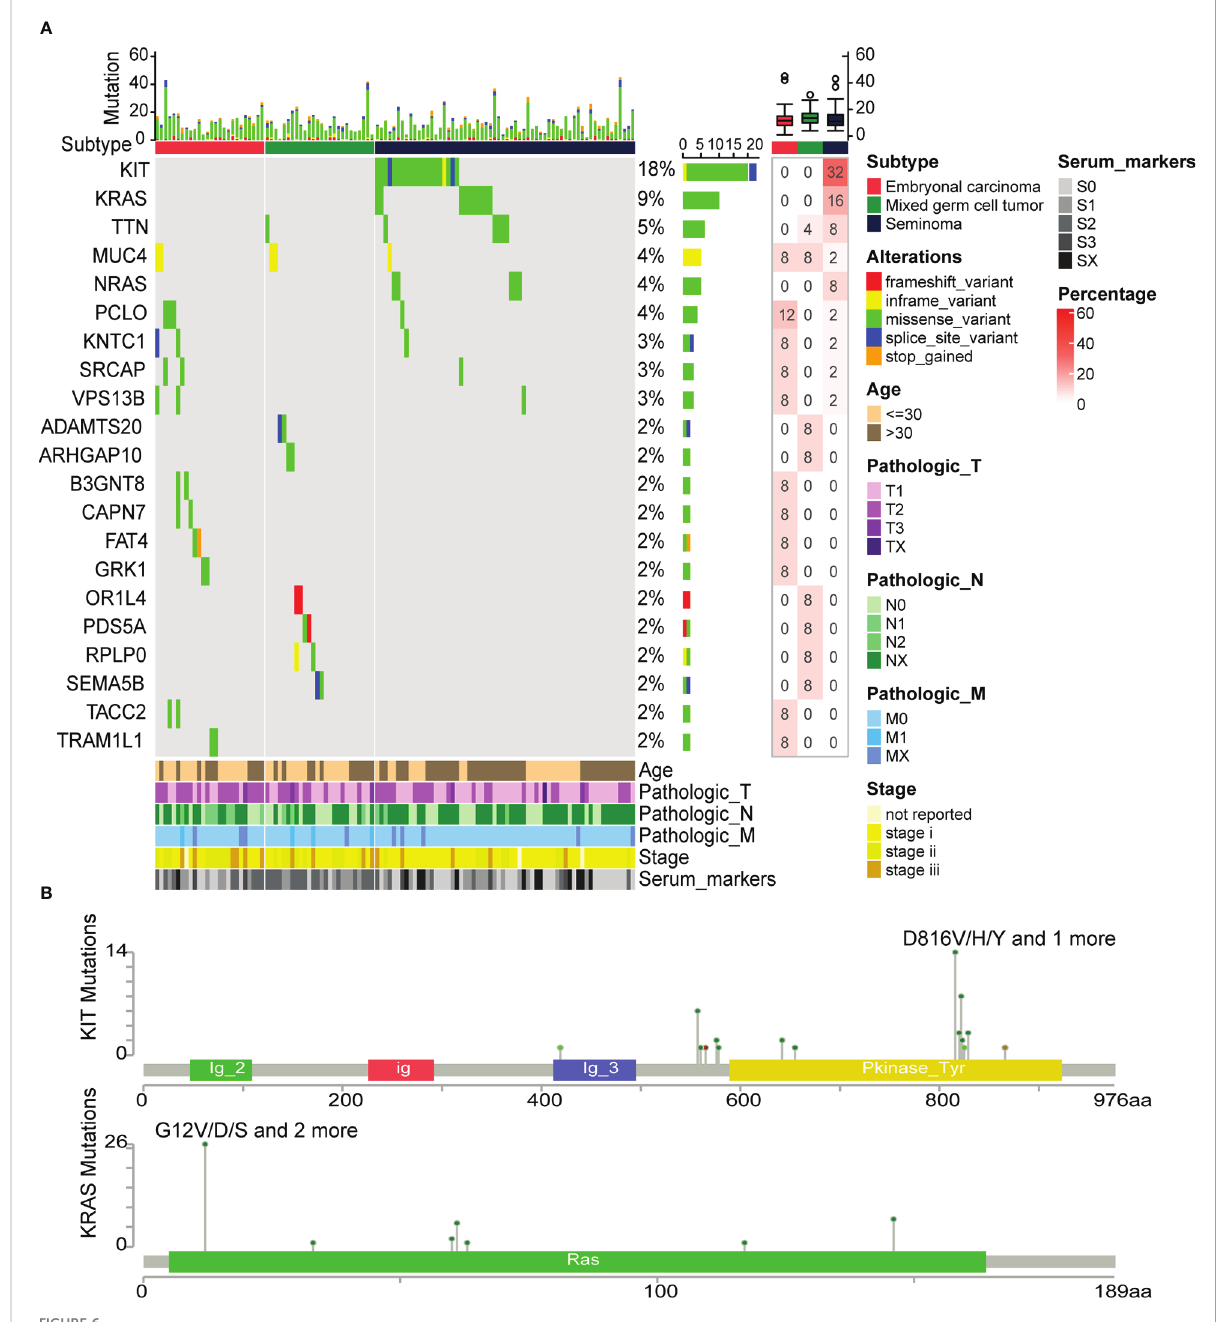
FIGURE 6 Differences in somatic mutations between TGCT subtypes. (A) The somatic mutations between embryonal carcinoma, mixed germ cell tumor and seminoma, and the percentage of mutated genes in each group (frequency>1%). (B) The mutation site map of high-frequency mutation genes (KIT and